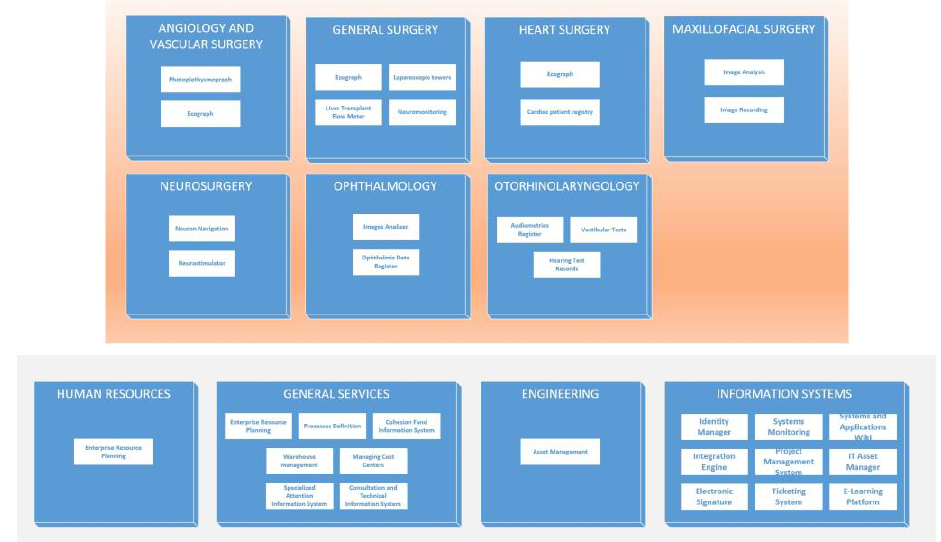
Figure 5. Relationship of information systems within clinical areas (III).